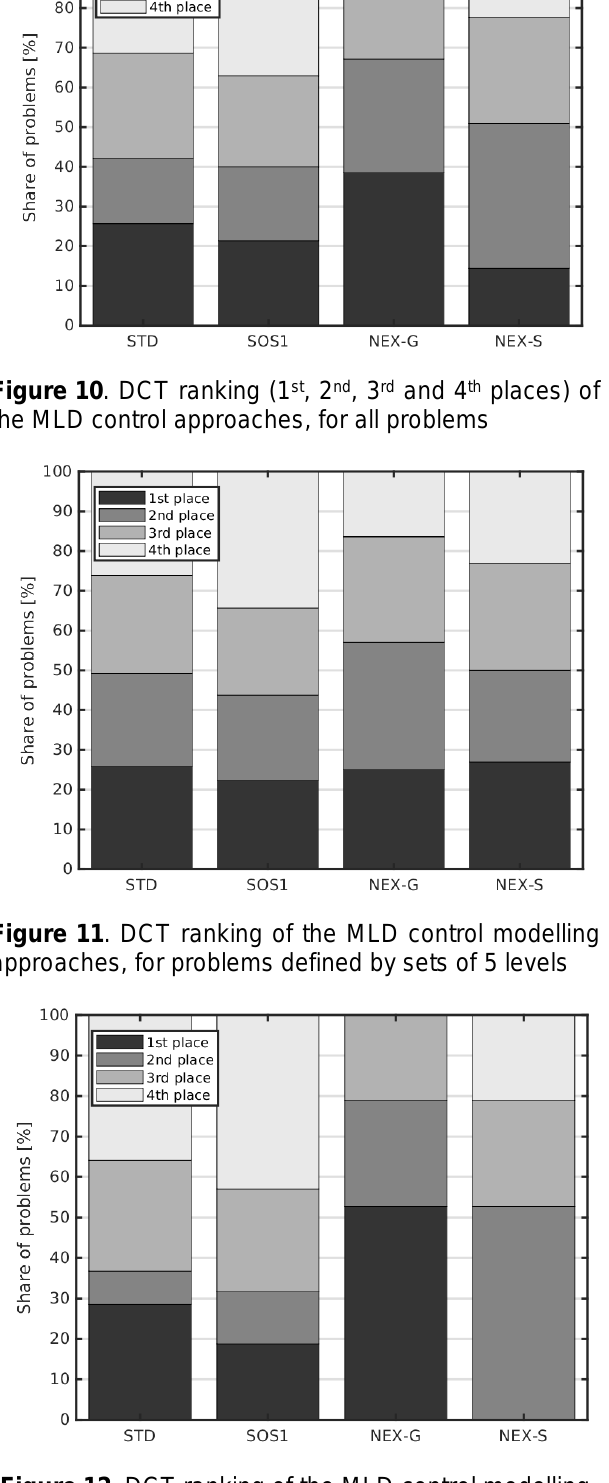
Figure 12 . DCT ranking of the MLD control modelling approaches, for problems defined by sets of 10